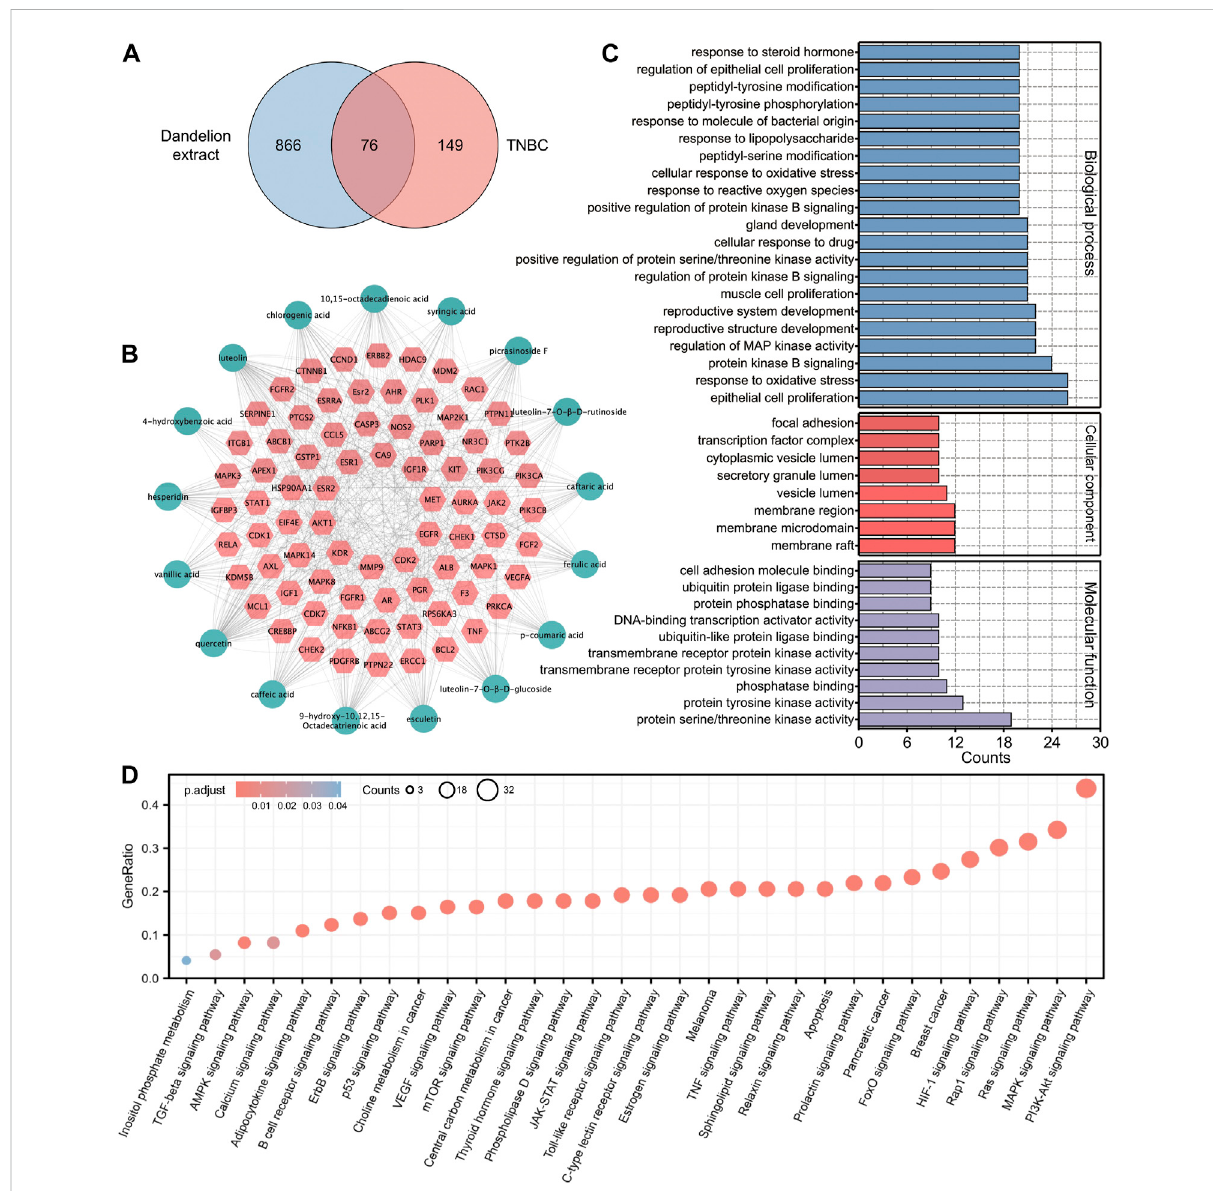
FIGURE 3 Network pharmacology analysis predicted the underlying regulatory mechanisms of dandelion extract against TNBC. (A) Venny diagram of the overlapping targets of dandelion extract and TNBC. (B) Compounds-disease-targets network. The pink diamond indicated the overlapping genes and the light green circles indicated the compounds in dandelion extract. (C) GO analysis for the overlapping genes. The x -axis represents the gene counts,andthe y -axisrepresentstheenrichedterms.( p < 0.05 ). (D) KEGGpathwayenrichmentfortheoverlappinggenes.The x -axisrepresents the enriched terms, and the y -axis represents the gene ratio ( p < 0.05